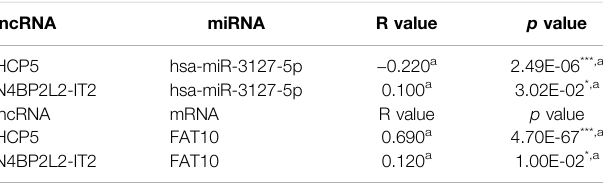
TABLE1| CorrelationanalysisbetweenlncRNAandhsa-miR-3127-5porlncRNA and FAT10 in SKCM via starBase database.